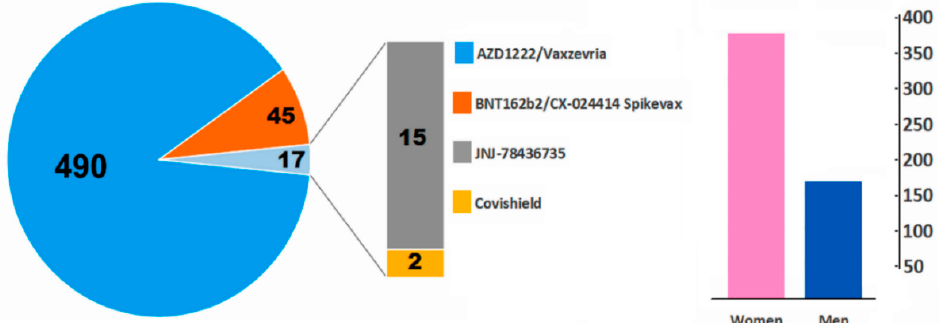
Figure 2. Summary of included cases ( n = 552) with CVST after vaccination. The women/men ratio was 2.25.